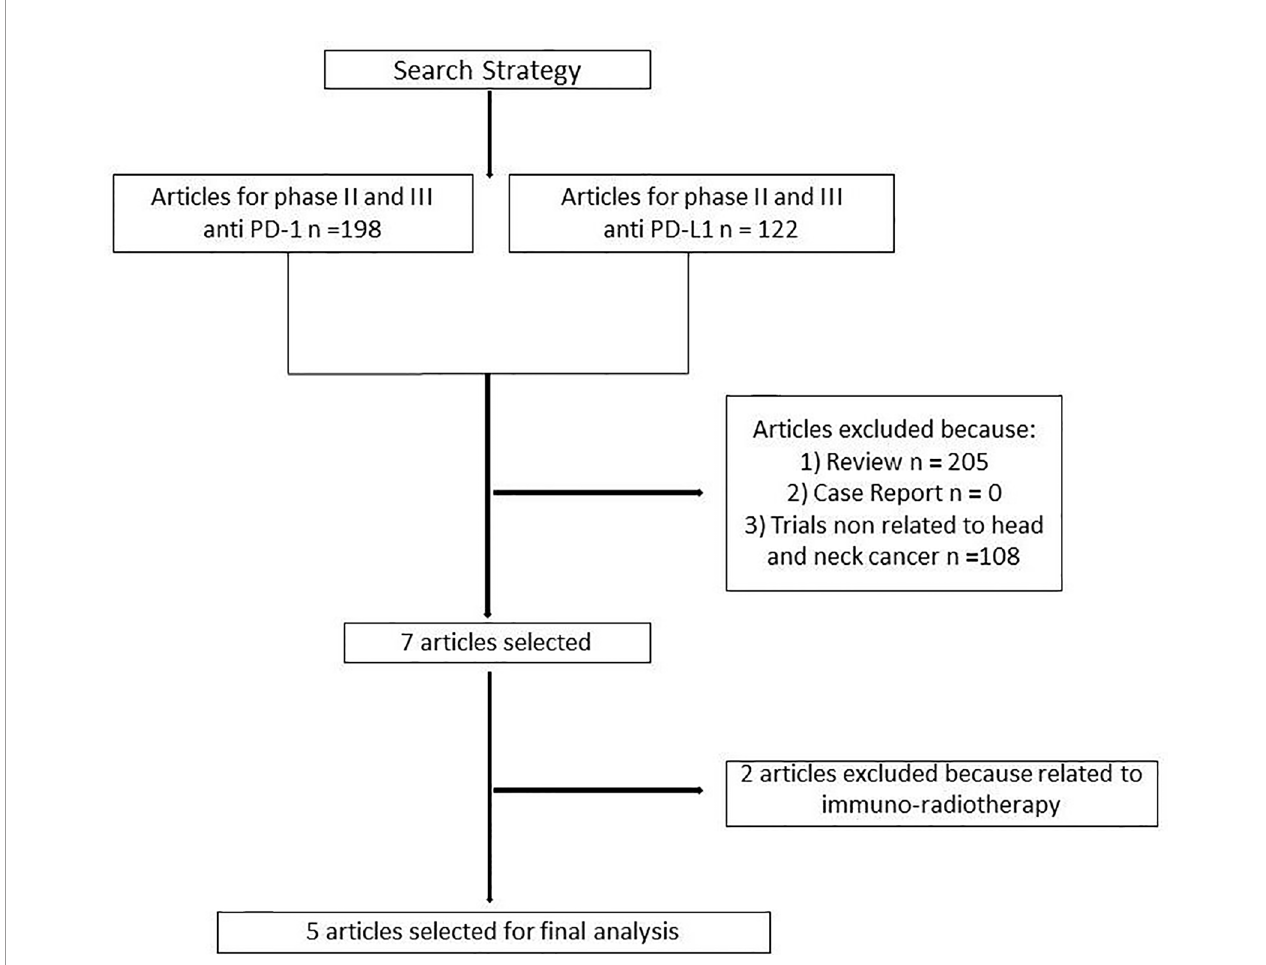
FIGURE 1 | Diagram of selection process for trials included in